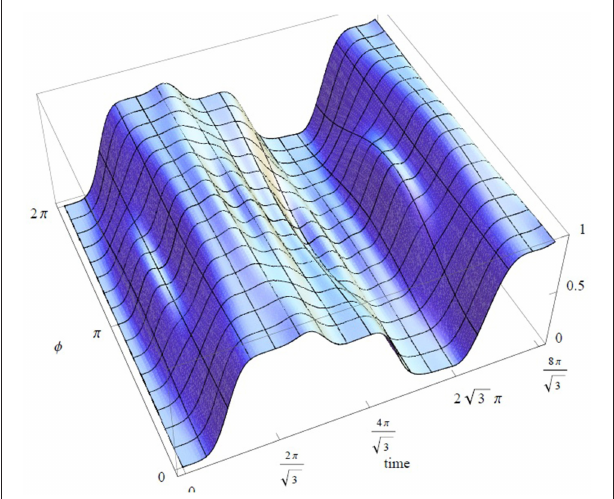
FIGURE 6 | Probability (Equation 23) as a function of time t and the center-of-mass phase φ , for α on φ is nontrivial and has the same periodicity as the atomic center-of-mass phase, similarly to a Youngian interference pattern. However, both atomic peaks arrive through the same path, and the self-interfering photons are emitted from the same point in